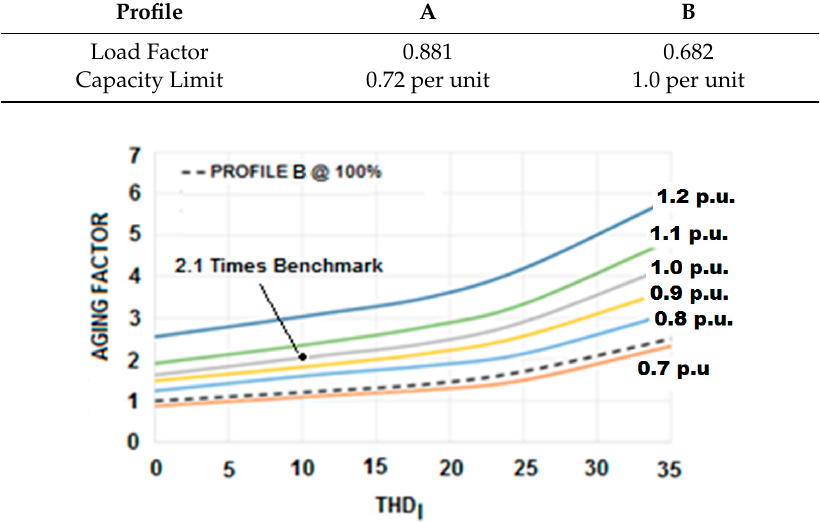
Figure 5. Comparison of aging induced by Profile B with peak energy demand = 1.0 per unit and Profile A with energy demand ranging between 0.7 and 1.2 per unit. Table 3. Capacity Rating (% Nameplate) for Profile A & B.